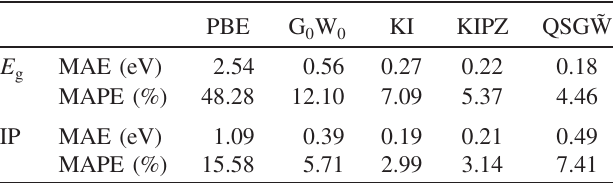
TABLE I. Meanabsolute errors(MAE,ineV)andmeanabsolute percent errors (MAPEs, in percent) with respect to experiments for (i) band gaps of 16 solids presented in Fig. 2 for which exper- imental, G 0 W 0 , and quasiparticleself-consistentGW withapproxi- ˜ mate vertex-correction (QSG W) data are available (see Table II of the Supplemental Material [66] and Refs. [79 – 81]), and (ii) IP of six surfaces presented in Fig. 4. Experimental values for solid band gap and surfaces are taken from Refs. [80,82 – 84],